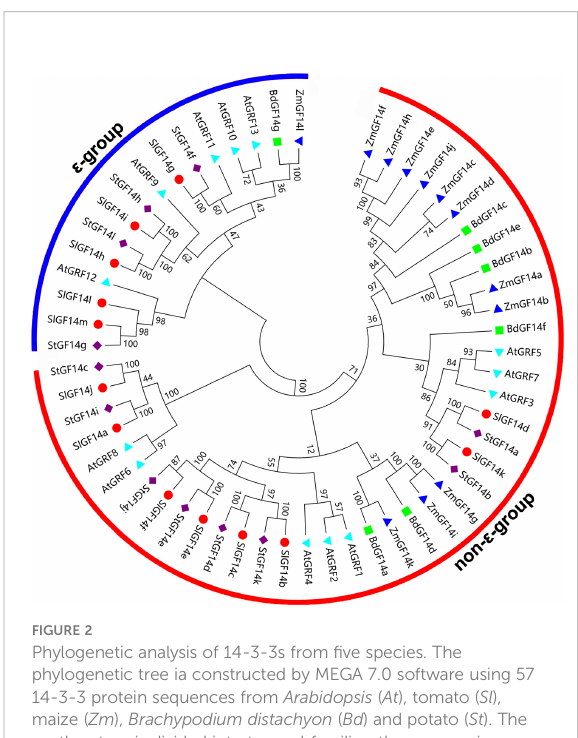
FIGURE 2 Phylogenetic analysis of 14-3-3s from fi ve species. The phylogenetic tree ia constructed by MEGA 7.0 software using 57 14-3-3 protein sequences from Arabidopsis ( At ), tomato ( Sl ), maize ( Zm ), Brachypodium distachyon ( Bd ) and potato ( St ). The rootless tree is divided into two subfamilies, the ϵ -group is marked with blue line, and the non- ϵ -group is marked by red